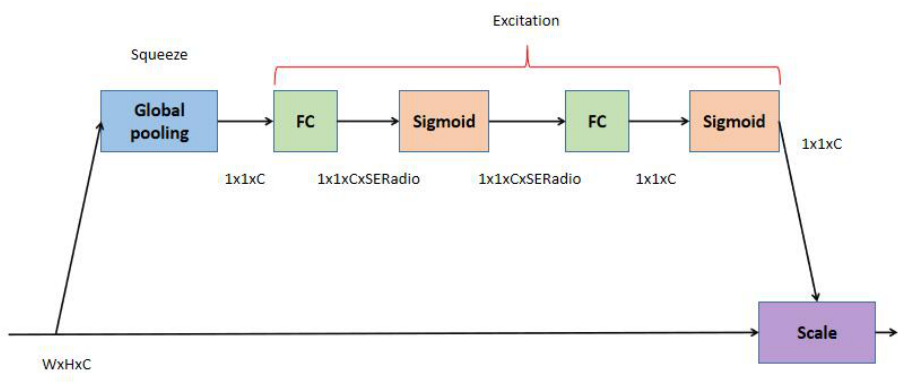
Figure 3. SE module.